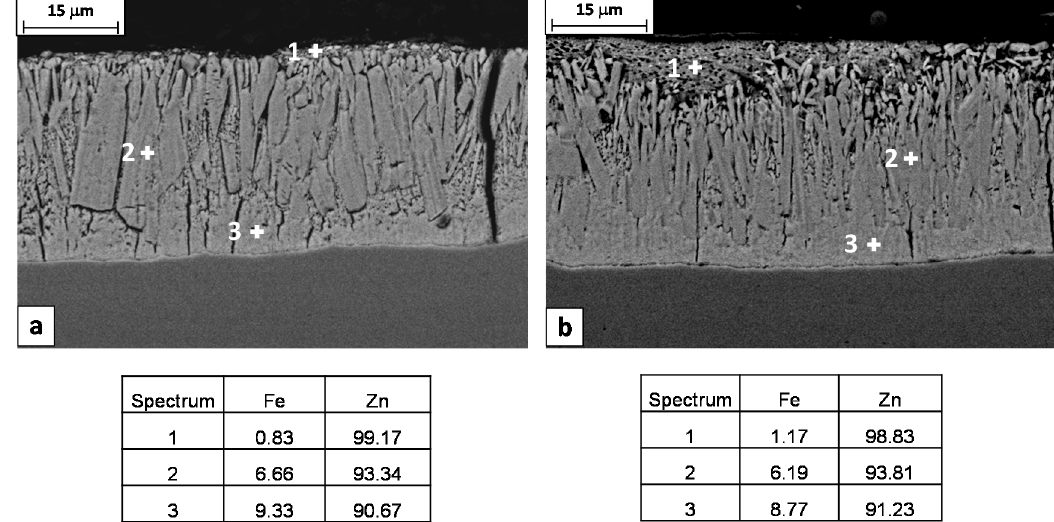
Figure 8. SEM images of longitudinal sections of ( a ) Steel 1 and ( b ) Steel 2 rods and EDS chemical analysis of the different coating layers (wt. %).